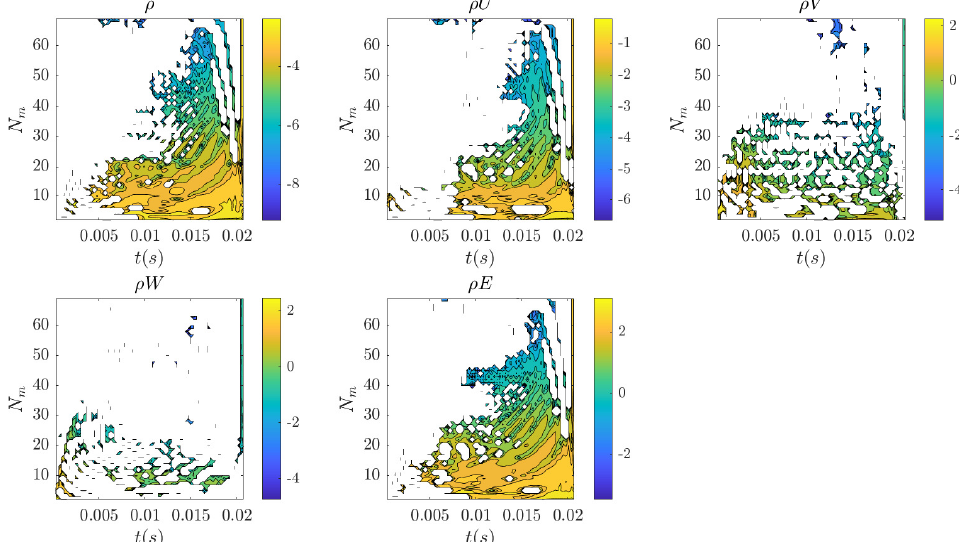
Figure 13. The log 10 ( (cid:101) diff ) considering POD only single ROM, versus the time and number of modes, delta wing test case. White regions correspond to (cid:101) diff = 0, i.e., the adaptive ROM selects